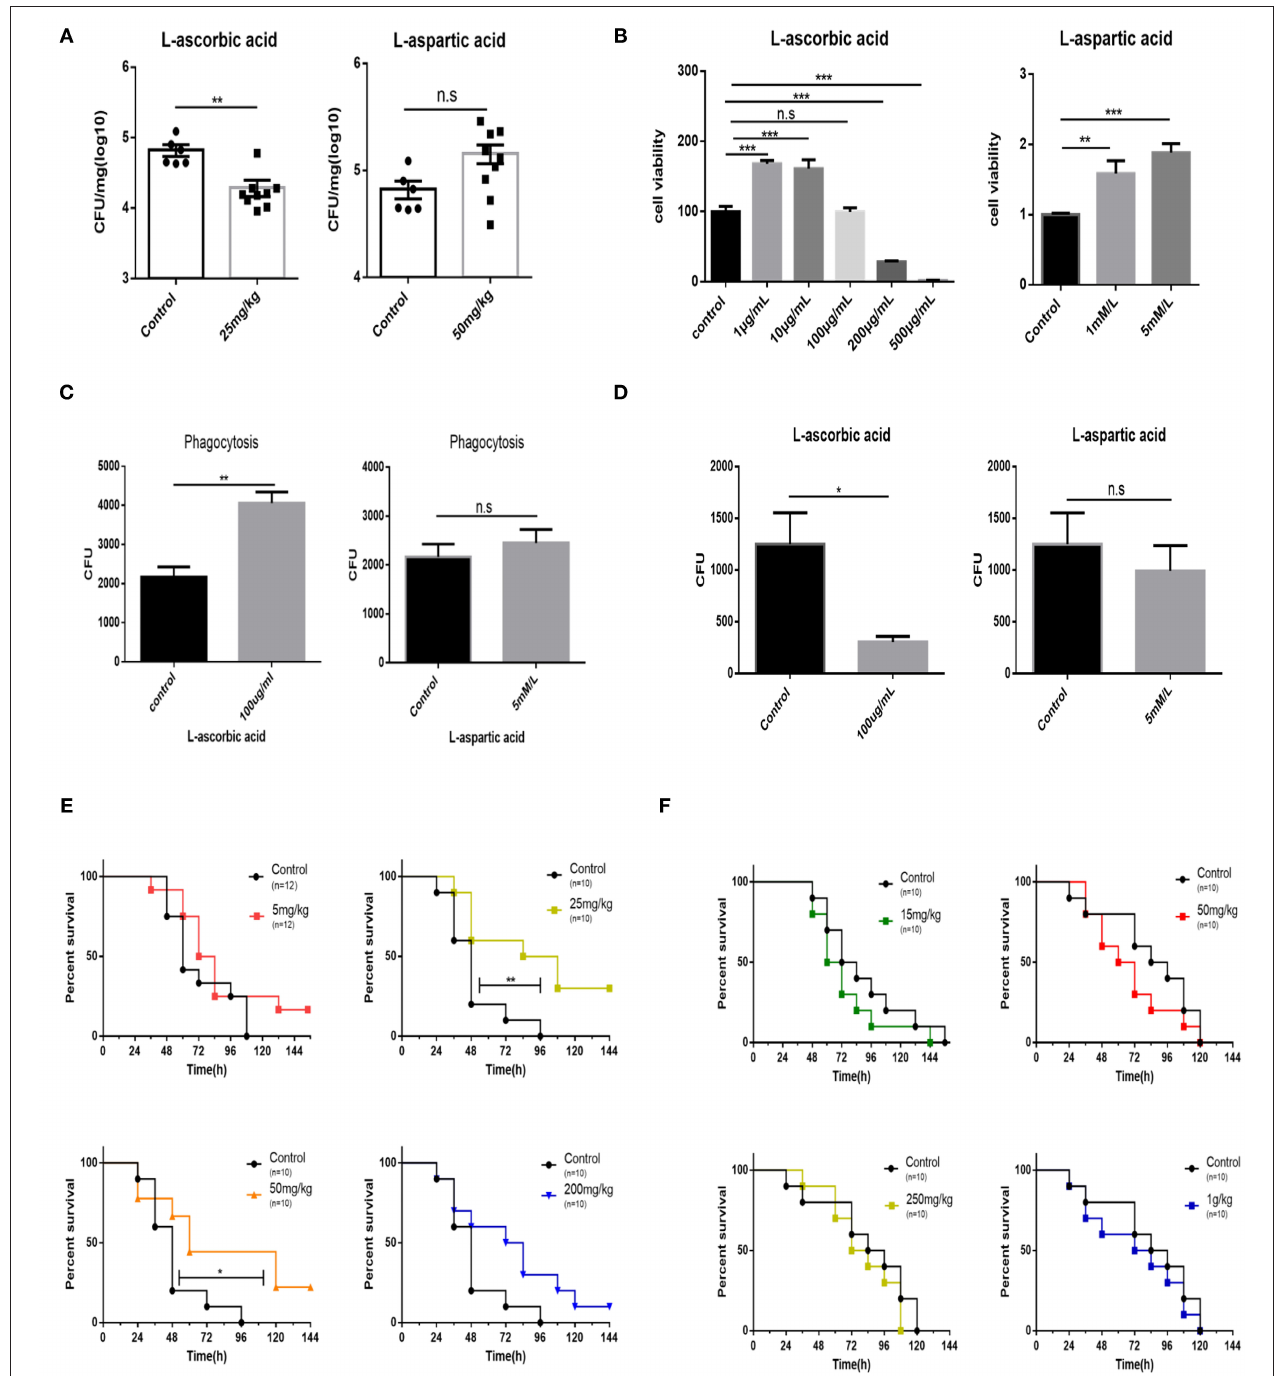
FIGURE 4 | Supplementation of AA results in reduction bacteria density of the lung, promotion of macrophage bactericidal activity, and partial prevention of mice from death. (A) The bacteria density of the mouse lung infected with 10 4 CFU log-phase growth PmCQ2 for 16h. Mice were supplemented with AA, Asp, or saline for 7 days before infection. Every point indicates an individual. (B) Analysis of mouse peritoneal macrophage cell viability under different concentrations of AA or Asp. Five repeats for each group. (C) The phagocytosis of mouse peritoneal macrophage on PmCQ2. Cells were supplemented with 100 µ g/ml AA, 5mM Asp, or saline. Five repeats for each group. (D) The number of live PmCQ2 in mouse peritoneal macrophage. Five repeats for each group. (E) The survival rates of mice supplemented with different doses of AA or saline for 7 days. Mice were intraperitoneally infected with 10 4 CFU log-phase growth PmCQ2. n represents how many mice were used in one experiment. (F) The survival rates of mice supplemented with different doses of Asp or saline for 7 days. Mice were intraperitoneally infected with 10 4 CFU log-phase growth PmCQ2. n represents how many mice were used in one experiment. *, **, and *** represent P < 0.05, P < 0.01, and P < 0.001, respectively.